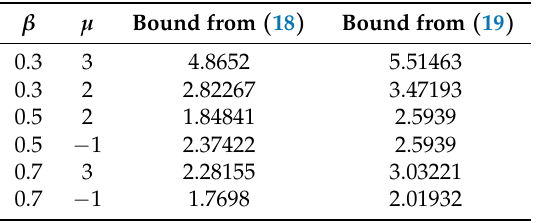
Table 1. Comparison of Fekete-Szegö